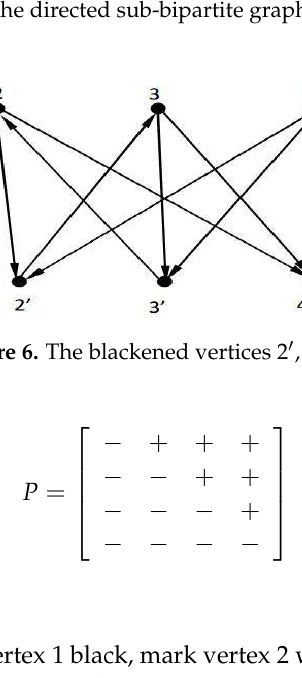
Figure 5. The directed sub-bipartite graph B ( U 1 , V 1 ) .